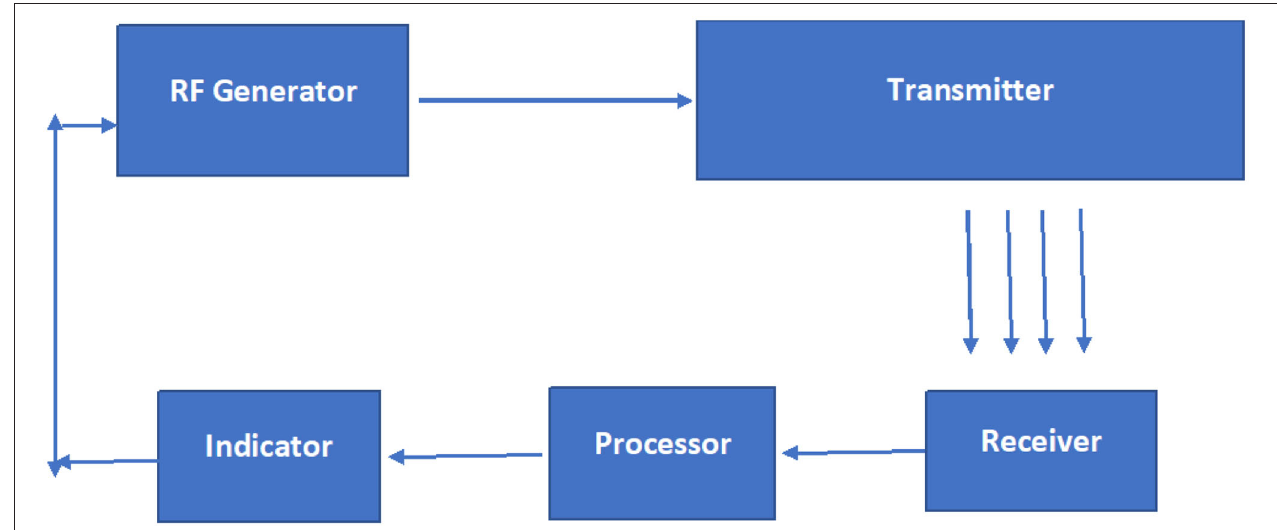
FIGURE 2 | A schematic diagram for skin hydration level detection.